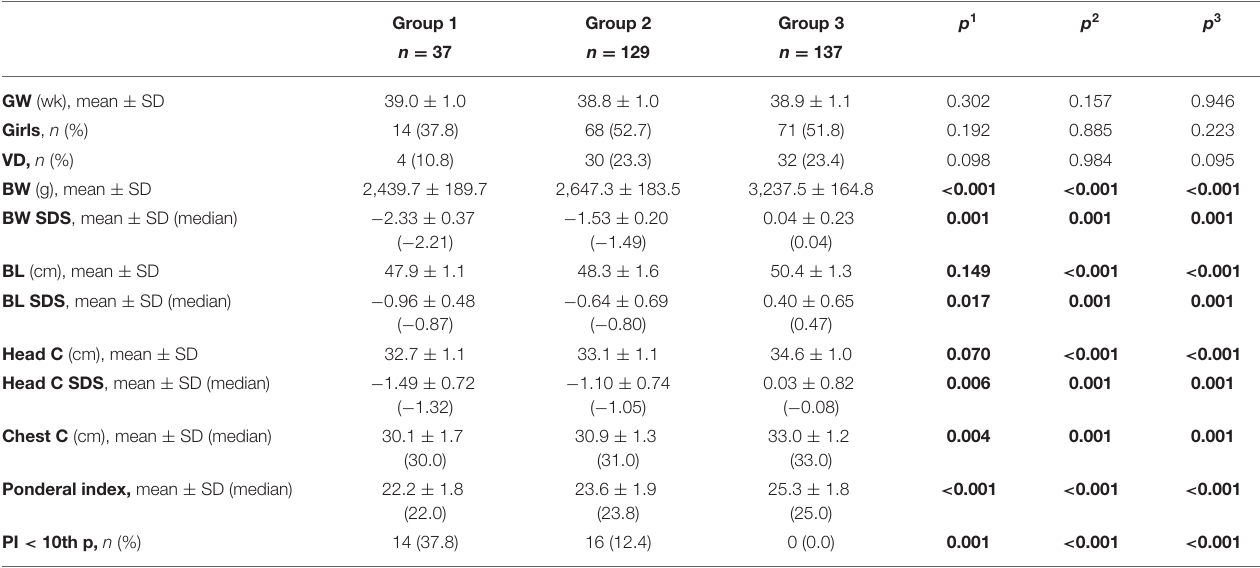
TABLE 1 | Demographic characteristics and birth anthropometry of the study